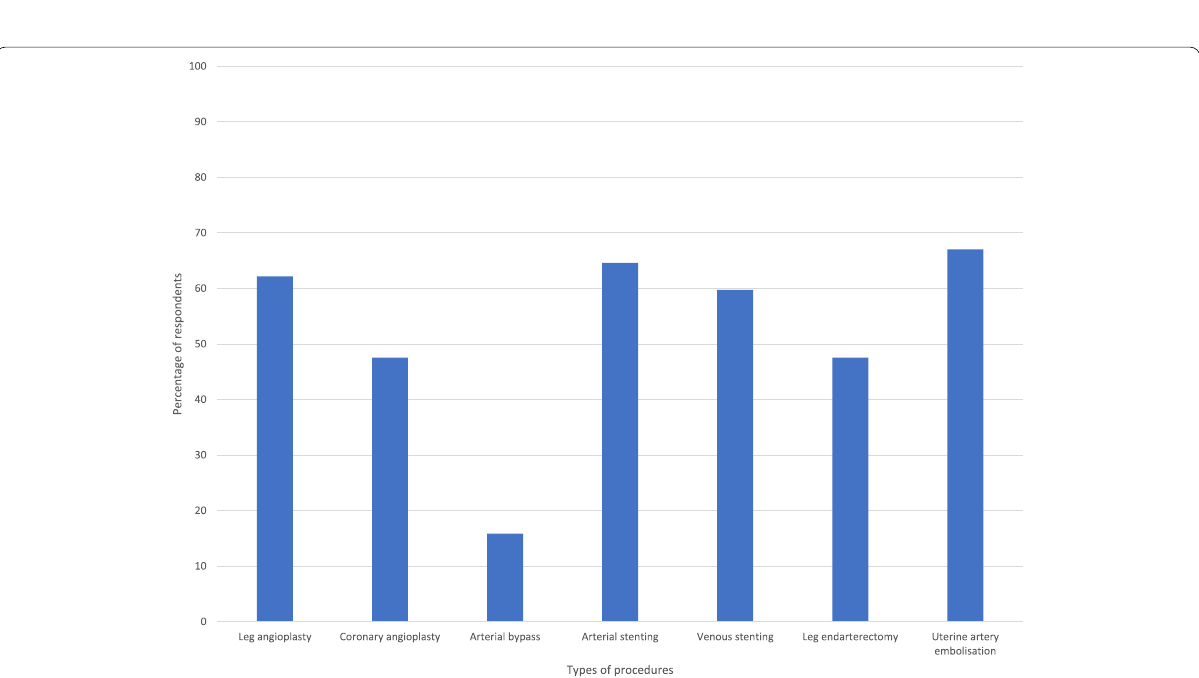
angioplasty (62%), arterial stenting (65%), venous stent- ing (60%) and uterine artery embolisation (67%). How- ever, students also incorrectly identified that IRs perform coronary angioplasty (48%), arterial bypass (16%) and endarterectomy (48%).